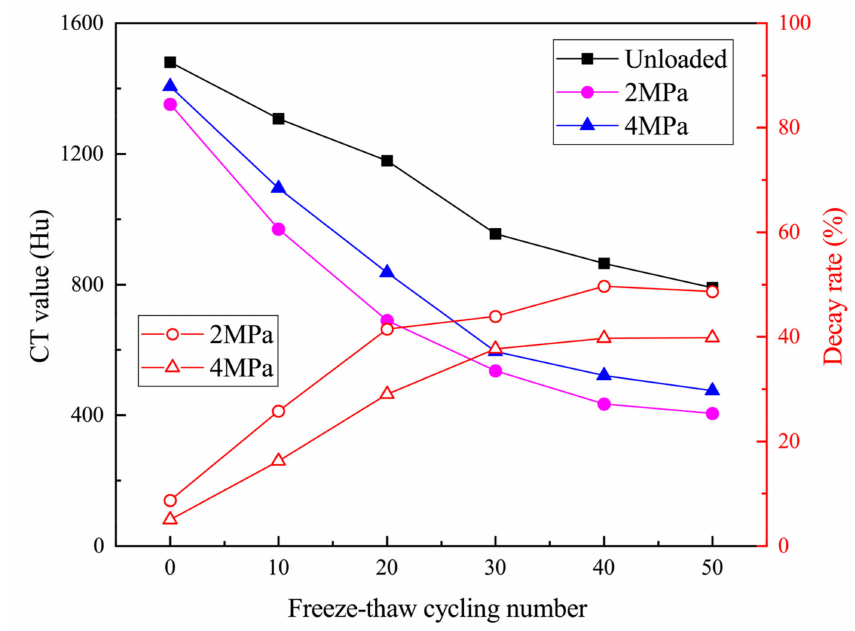
Figure 16. The CT value of specimen and decay rate of the CT value vs. different